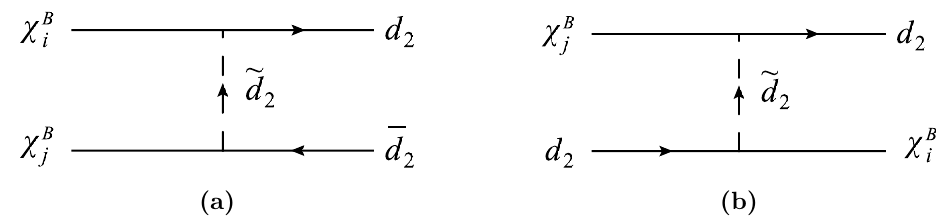
Figure 21. (a) Example of diagram contributing to bino pair annihilation to d 2 d 2 . (b) Example of a diagram contributing to bino conversion via scattering o(cid:11) quarks.